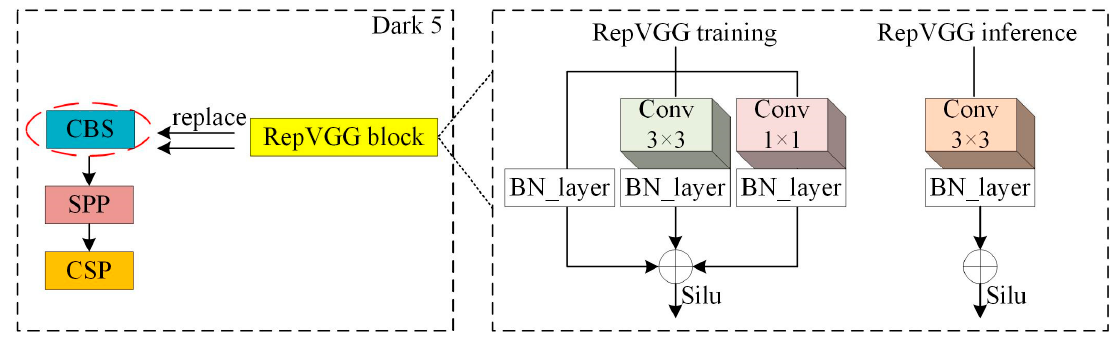
Figure 2. RepVGG block